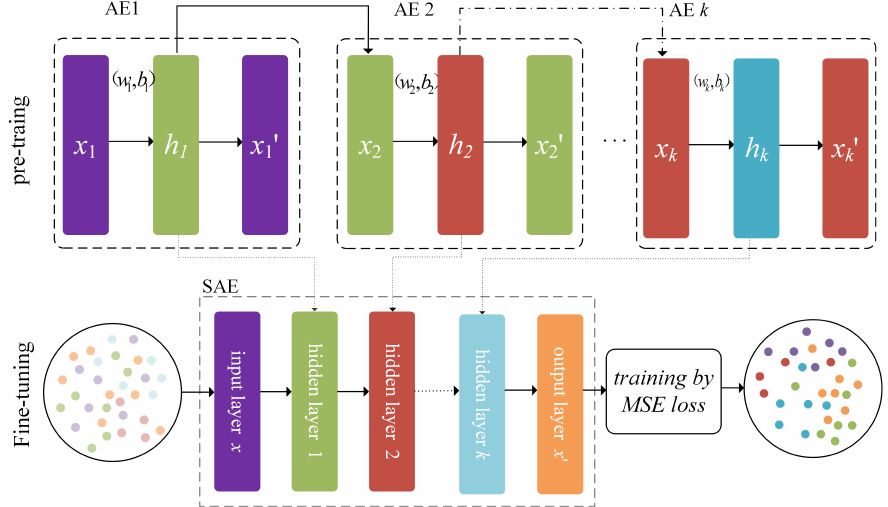
Figure 2. The training process of